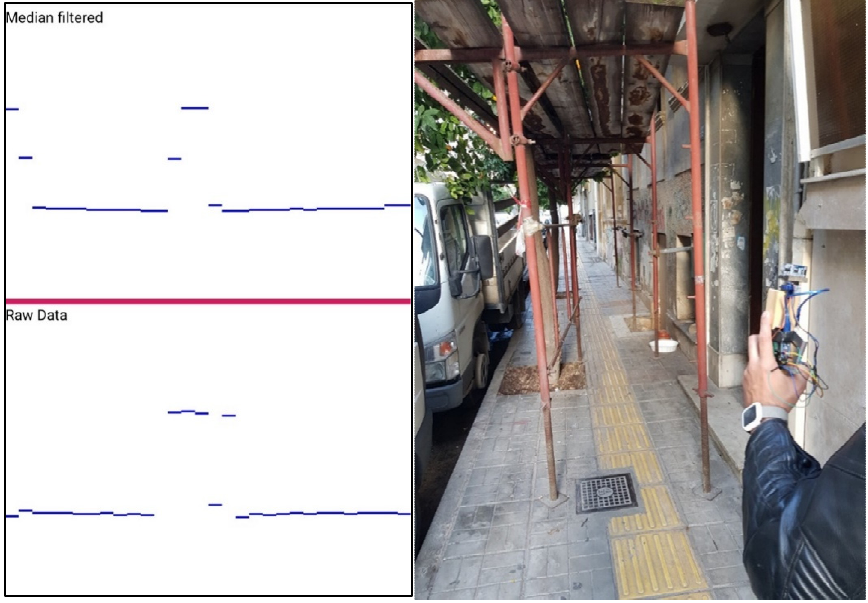
Figure 22. Response of sonar obstacle detection system.